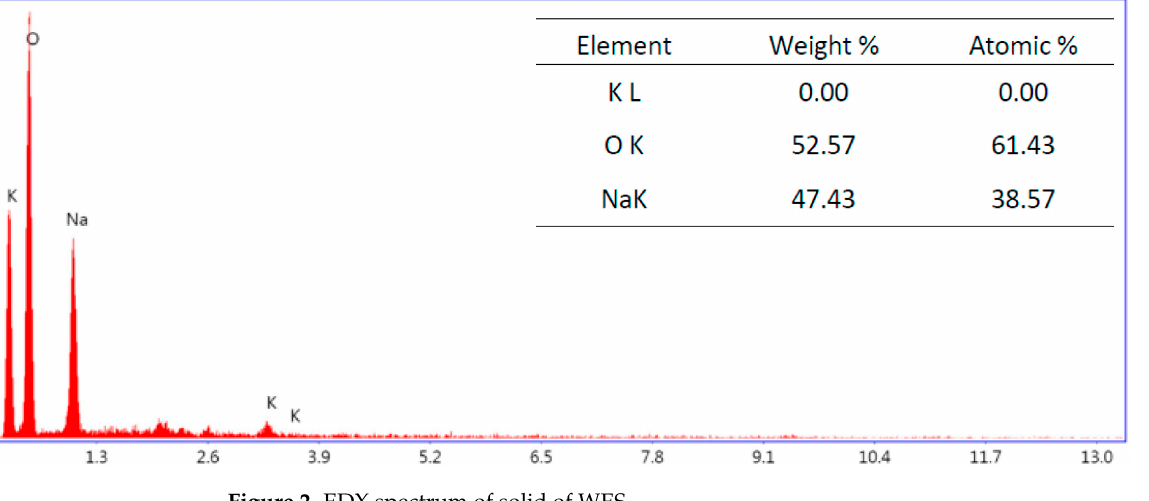
Figure 2. EDX spectrum of solid of WES.